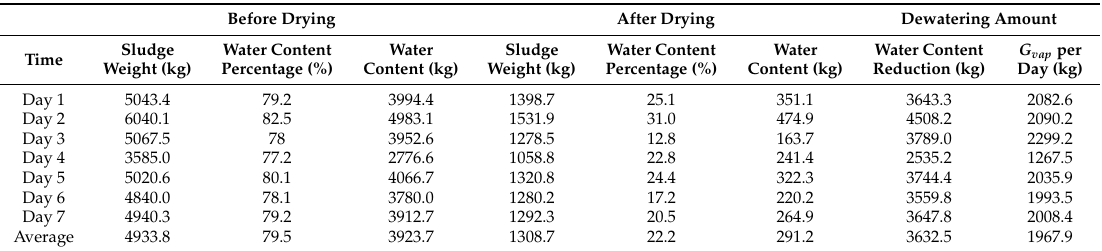
Table 2. Water content percentage before and after sludge drying treatment in experiments.